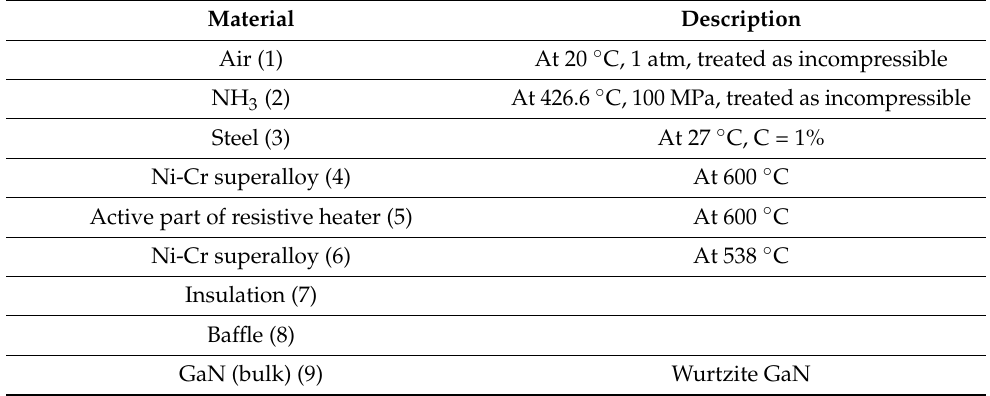
Table 1. Overview of materials used in simulation of temperature distribution and fluid flow.